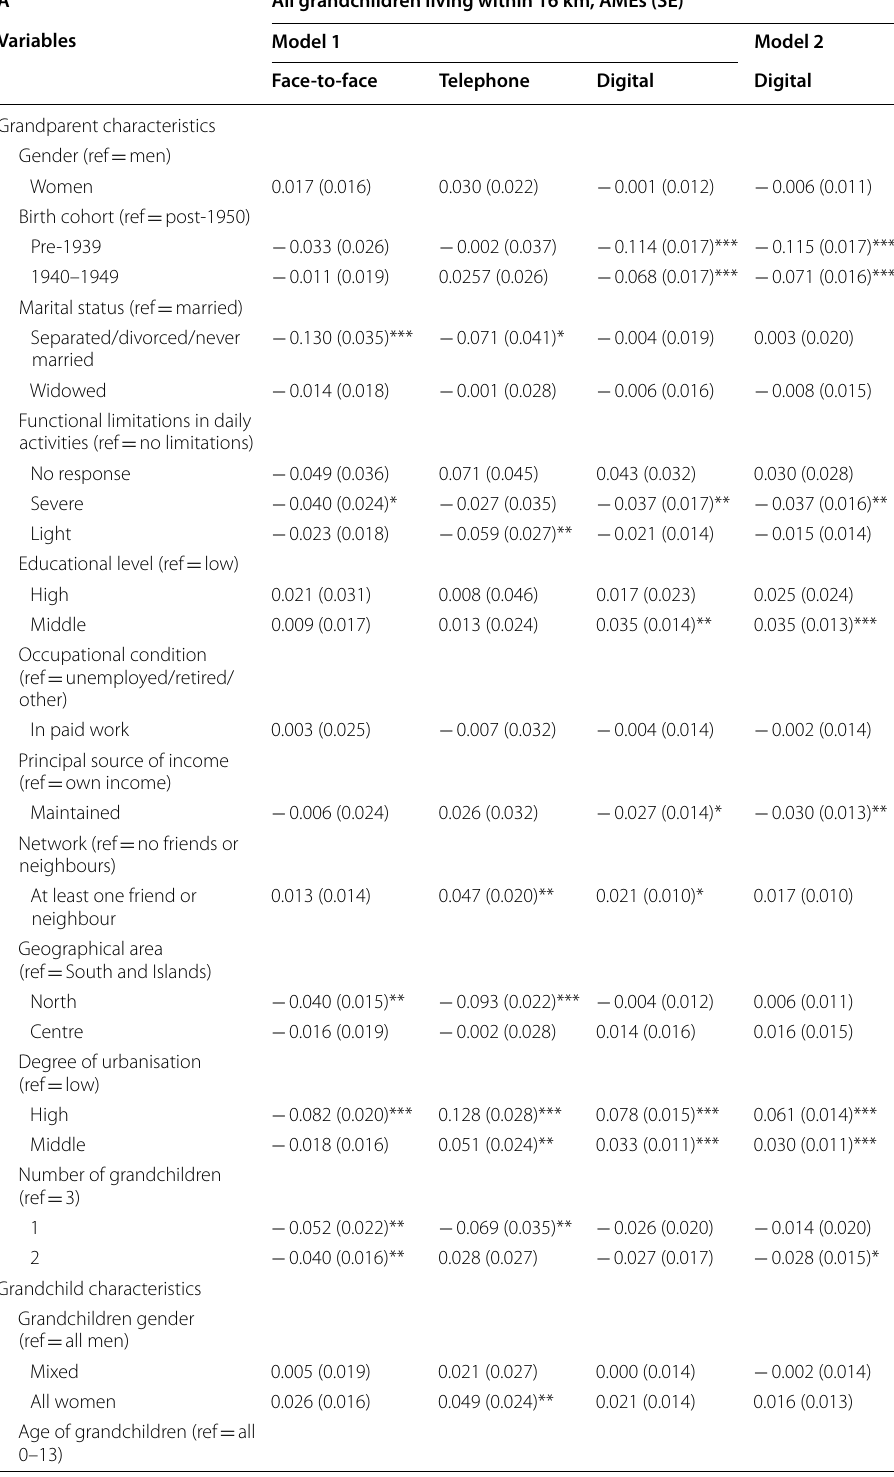
Table 3 Average marginal effects and robust standard errors from logistic regression models of grandparent–grandchild contact, for grandparents stratified by grandchildren’s living proximity: face-to-face, telephone and digital